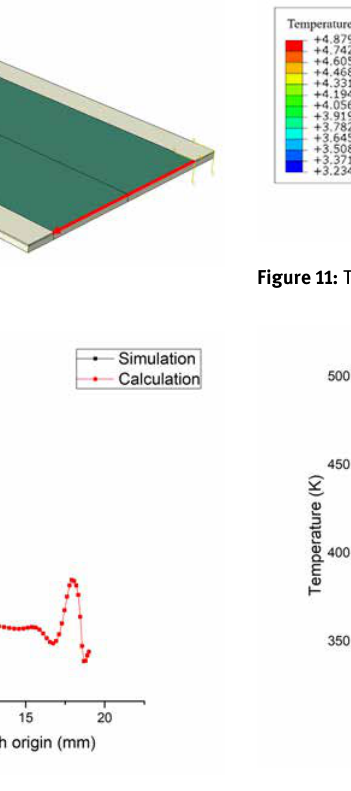
425 K [7], and in this simulation the predicted temperature is 423K, which matches well with the experimental result.